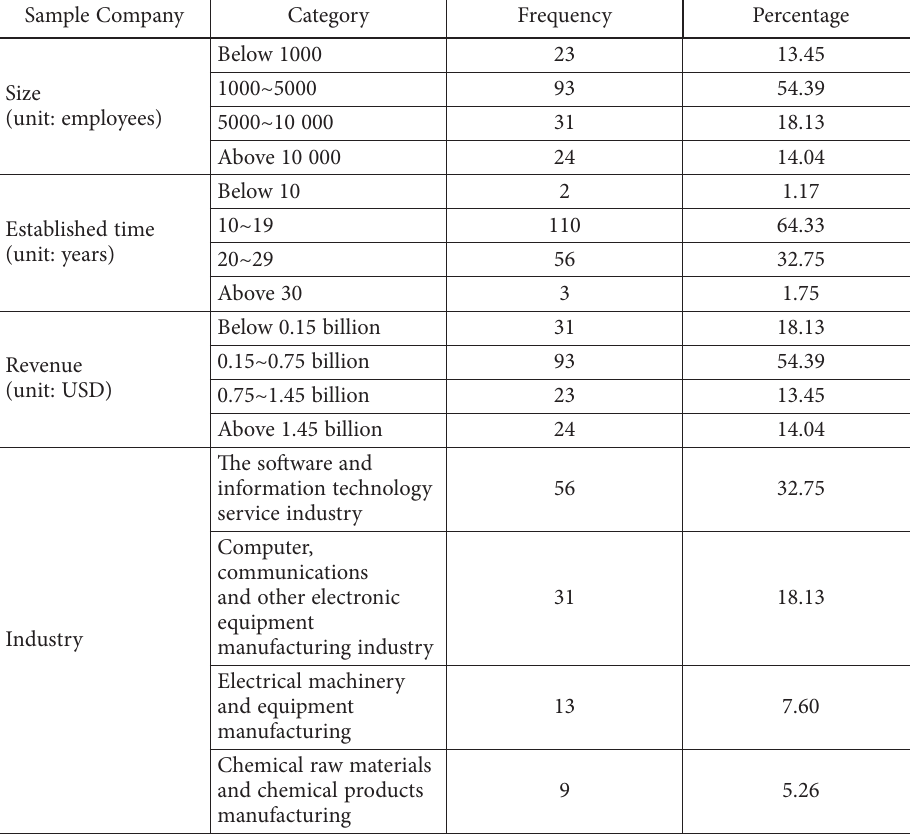
Table 2. Statistical analysis of sample characteristics Sample Company